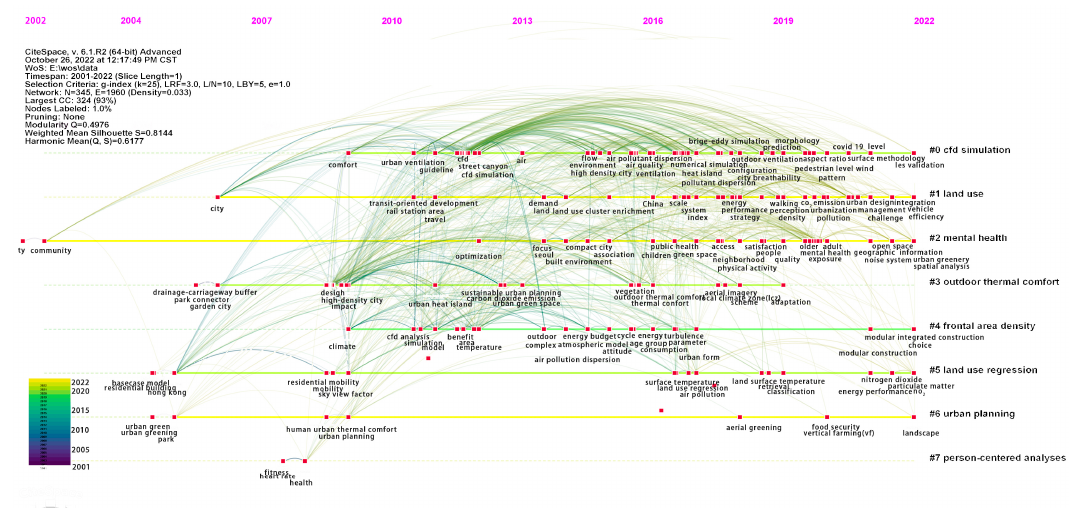
Figure 12. Timeline map of high-density city research from 2001 to 2022.